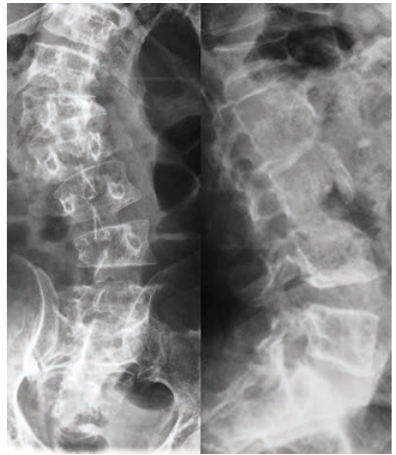
Fig. 2. Clinical photograph of the proband’s father showing similar clinical phenotype, normal facies, genu valgus deformities and brachydactyly.